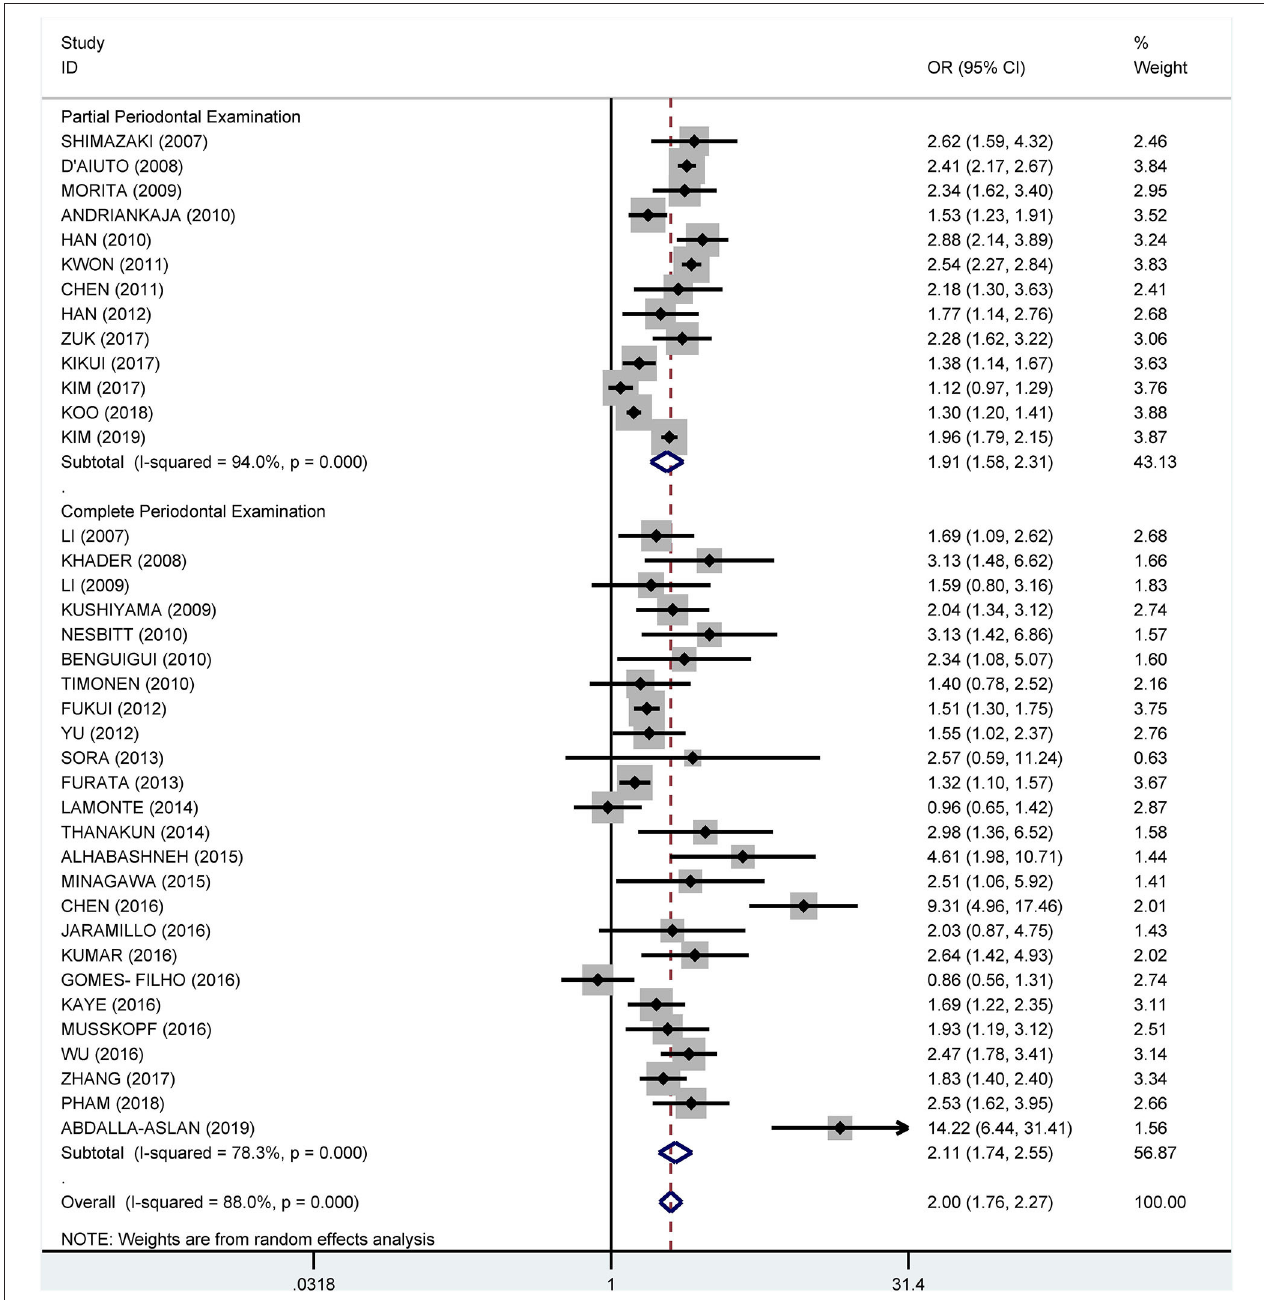
FIGURE 5 | Subgroup analysis of pooled crude odds ratios of the association between periodontitis and metabolic syndrome by the method of examination used to diagnose periodontitis.